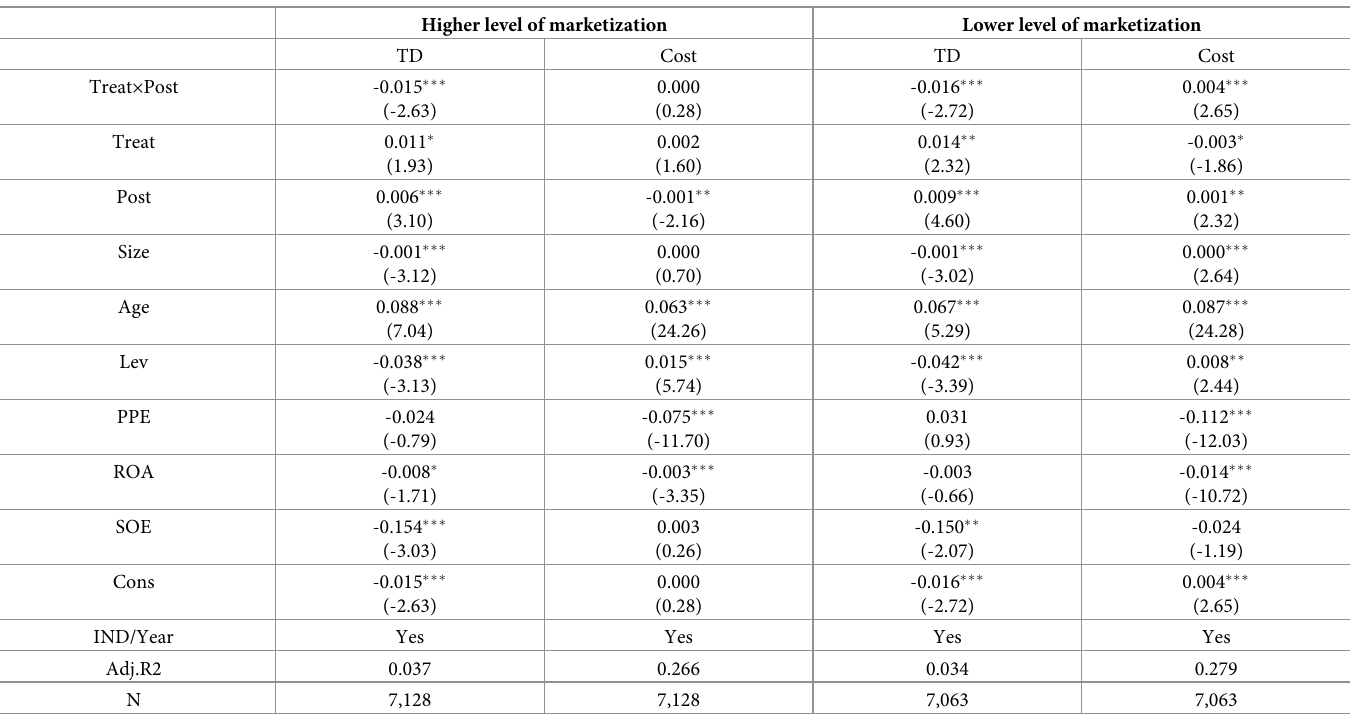
Table 10. Differences in the levels of financial market